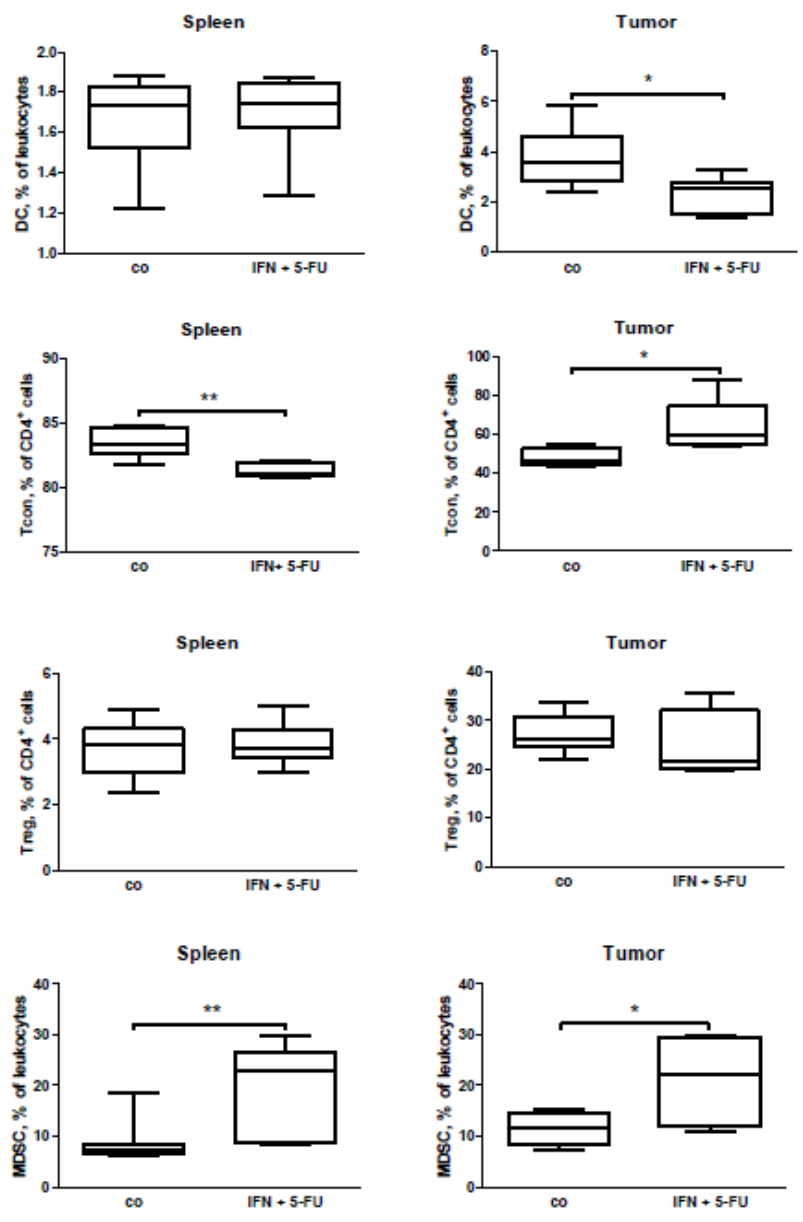
Figure 6. FACS analysis of DC, Tcon, Treg, and MDSC in the spleen and tumors of Panc02-bearing mice treated with a combination of IFN and 5-FU (IFN + 5-FU) and of contro-treated animals (co). Six to eight animals per group, * p < 0.05, and ** p < 0.01.